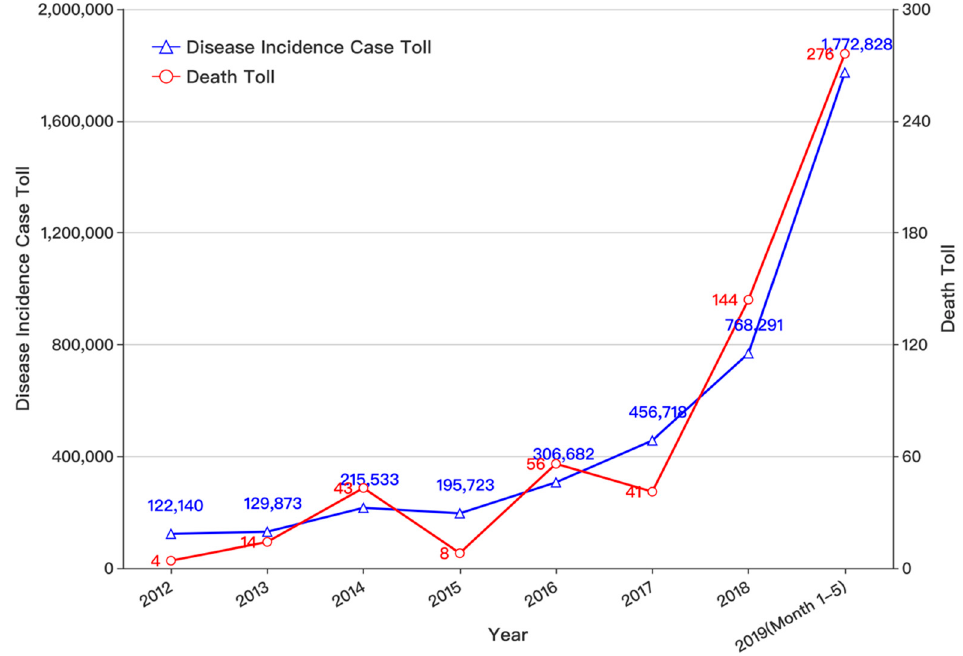
Figure 1. Number of People in the Incidences and Deaths from Flu in China.